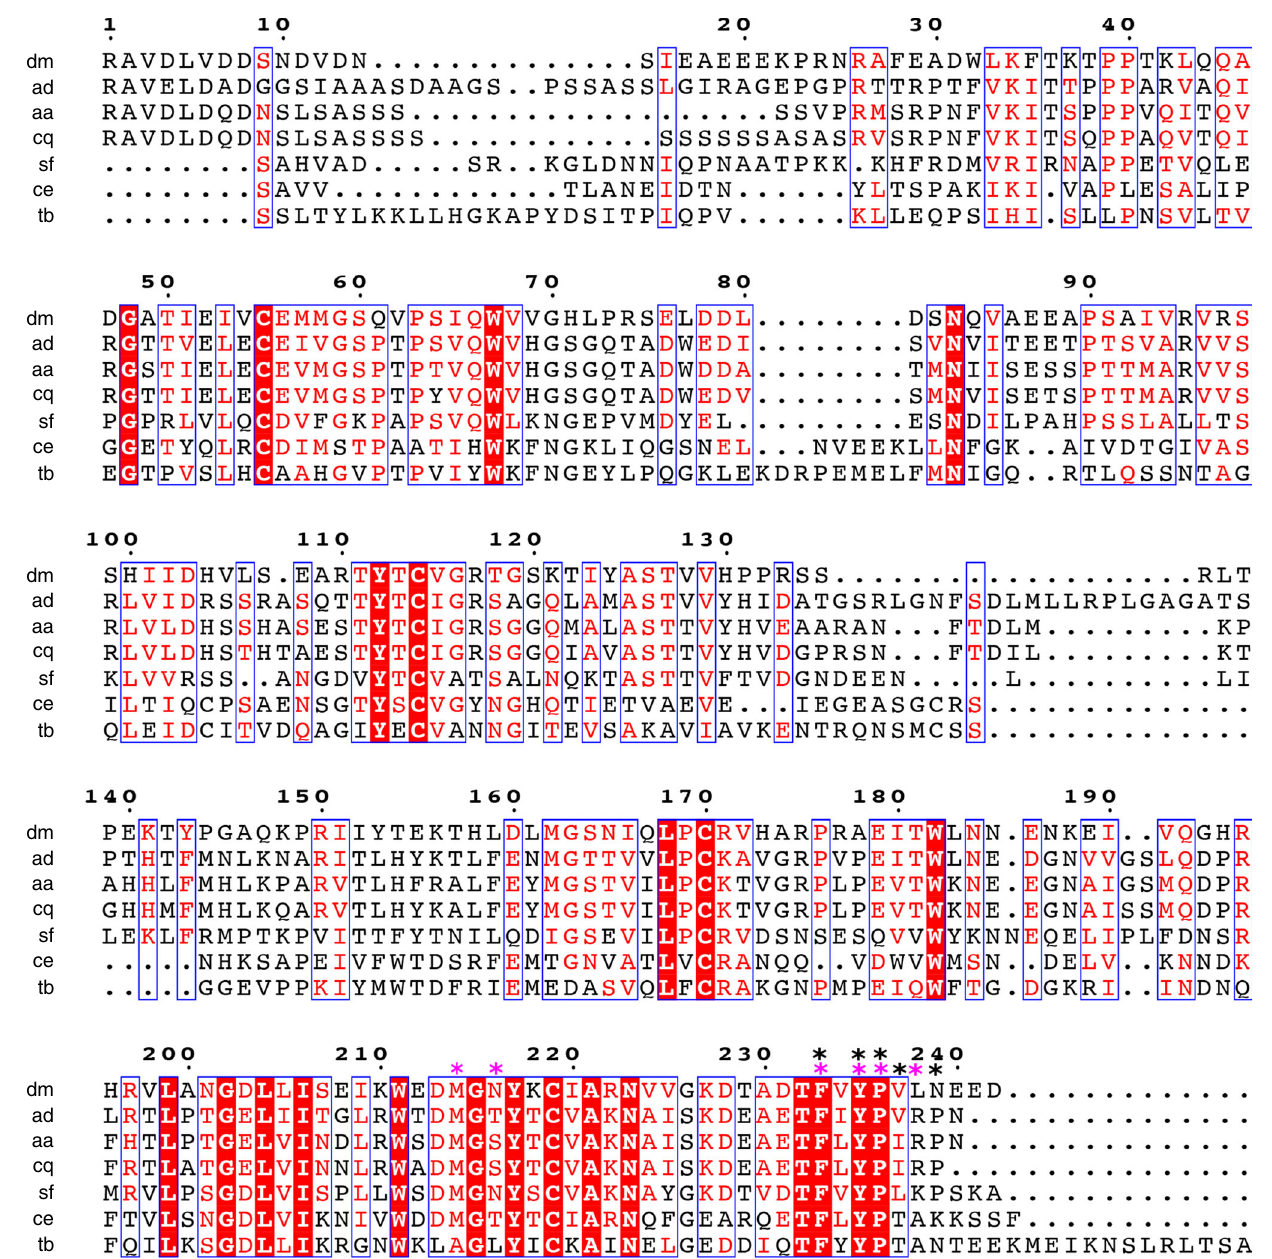
Fig. 7 Sequence alignment of some representative and putative IBPs. Sequence numbering as for the Imp-L2 structure; key residues for hormone binding observed in the holo-Imp-L2 structures are indicated by stars in magenta, while residues that lowered Sf -IBP hormone af fi nity more than fi ve times in Ala scanning experiment are marked by black stars. dm D. melanogaster Imp-L2, ad Anopheles darlingi , aa Aedes aegypti , cq Culex quinquefasciatus , sf